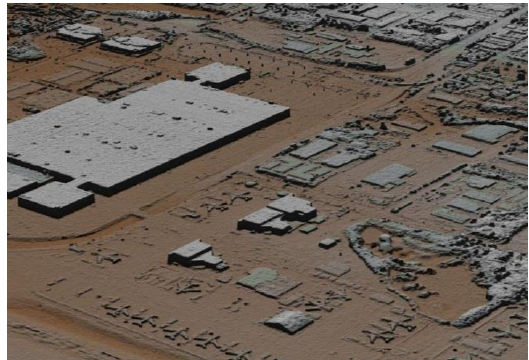
Figure 6: Visualization of ~3 km 2 near the Boeing facilities north of Seattle, WA as a detail from the nation-wide DSM. Point density at 1 m; nominal vertical error is at ± 1 m on solid surfaces.